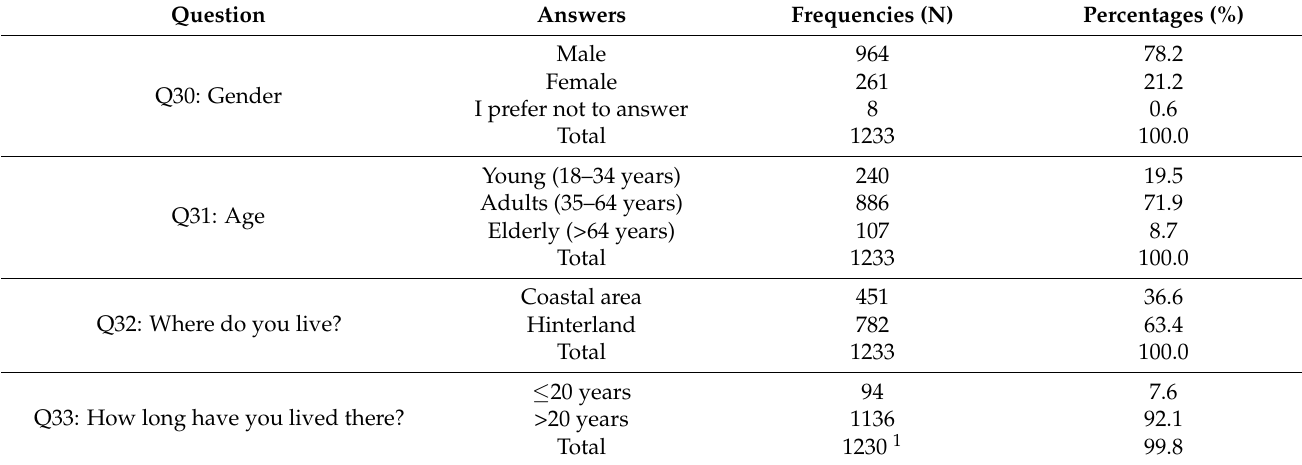
Table 2. Answers to the general part of the questionnaires (sample size = 1233